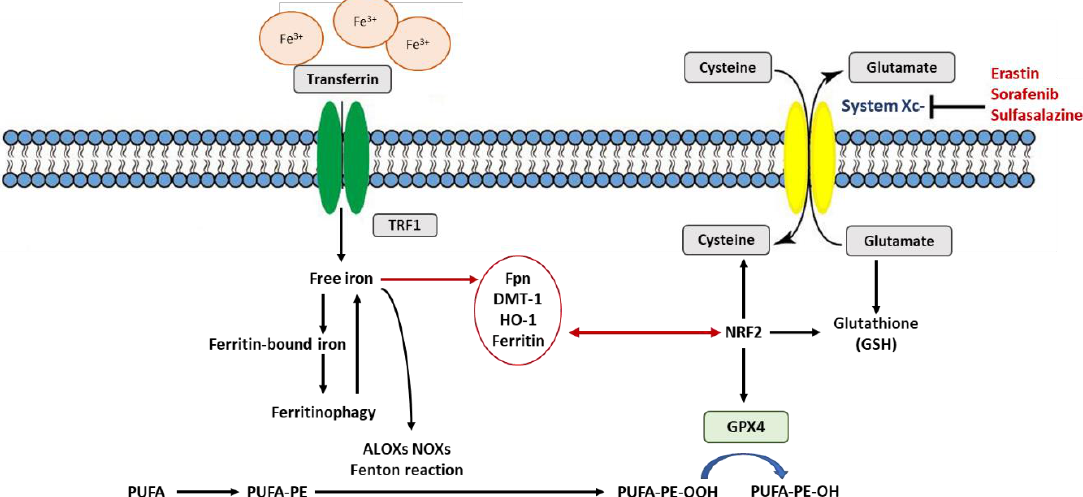
Figure 2. Schematic representation of the molecular pathways of ferroptosis regulation. The indicated pathways regulate ferroptosis sensitivity. Abbreviations: TFR1: transferrin receptor1;